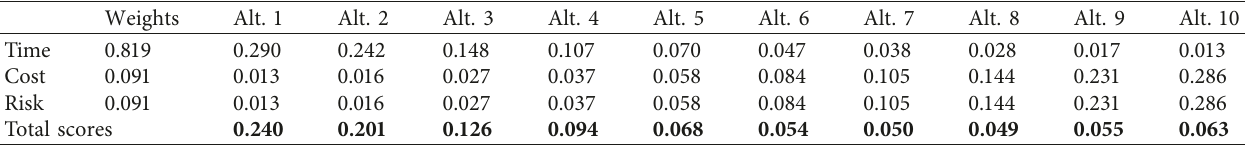
Table 7: Results of the FMCDM model (case